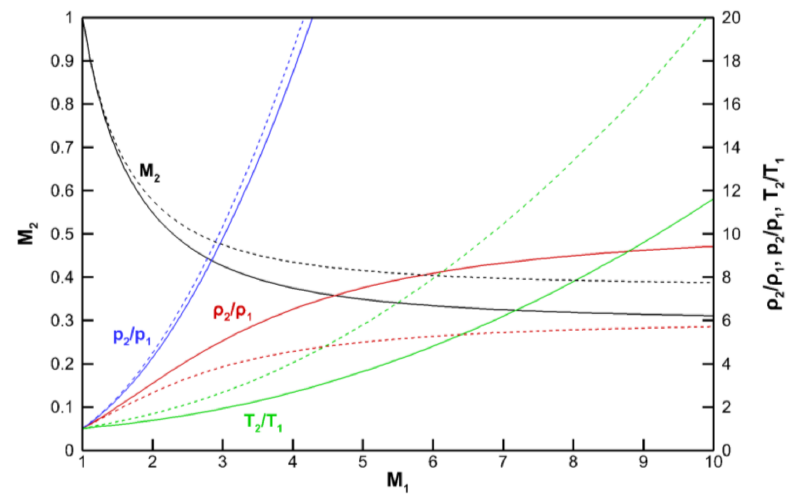
Figure 18. Changes in property across a normal shock wave (solid: air; dashed: burnt